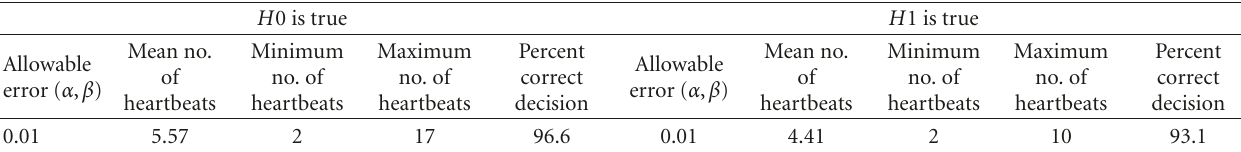
Table 3: E ff ects of varying levels of